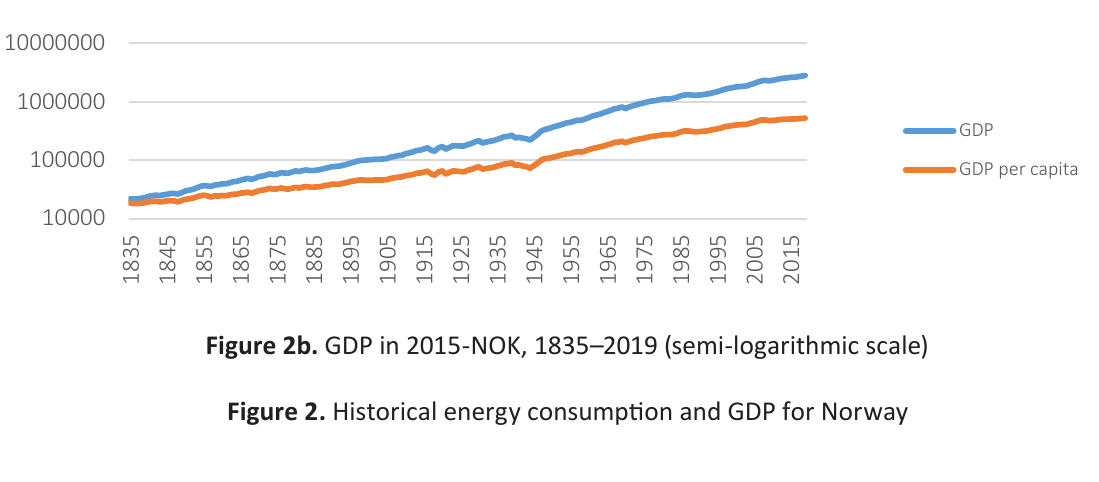
Figure 2a. Energy consumption by source of production in Petajoule derived units, 1835–2012